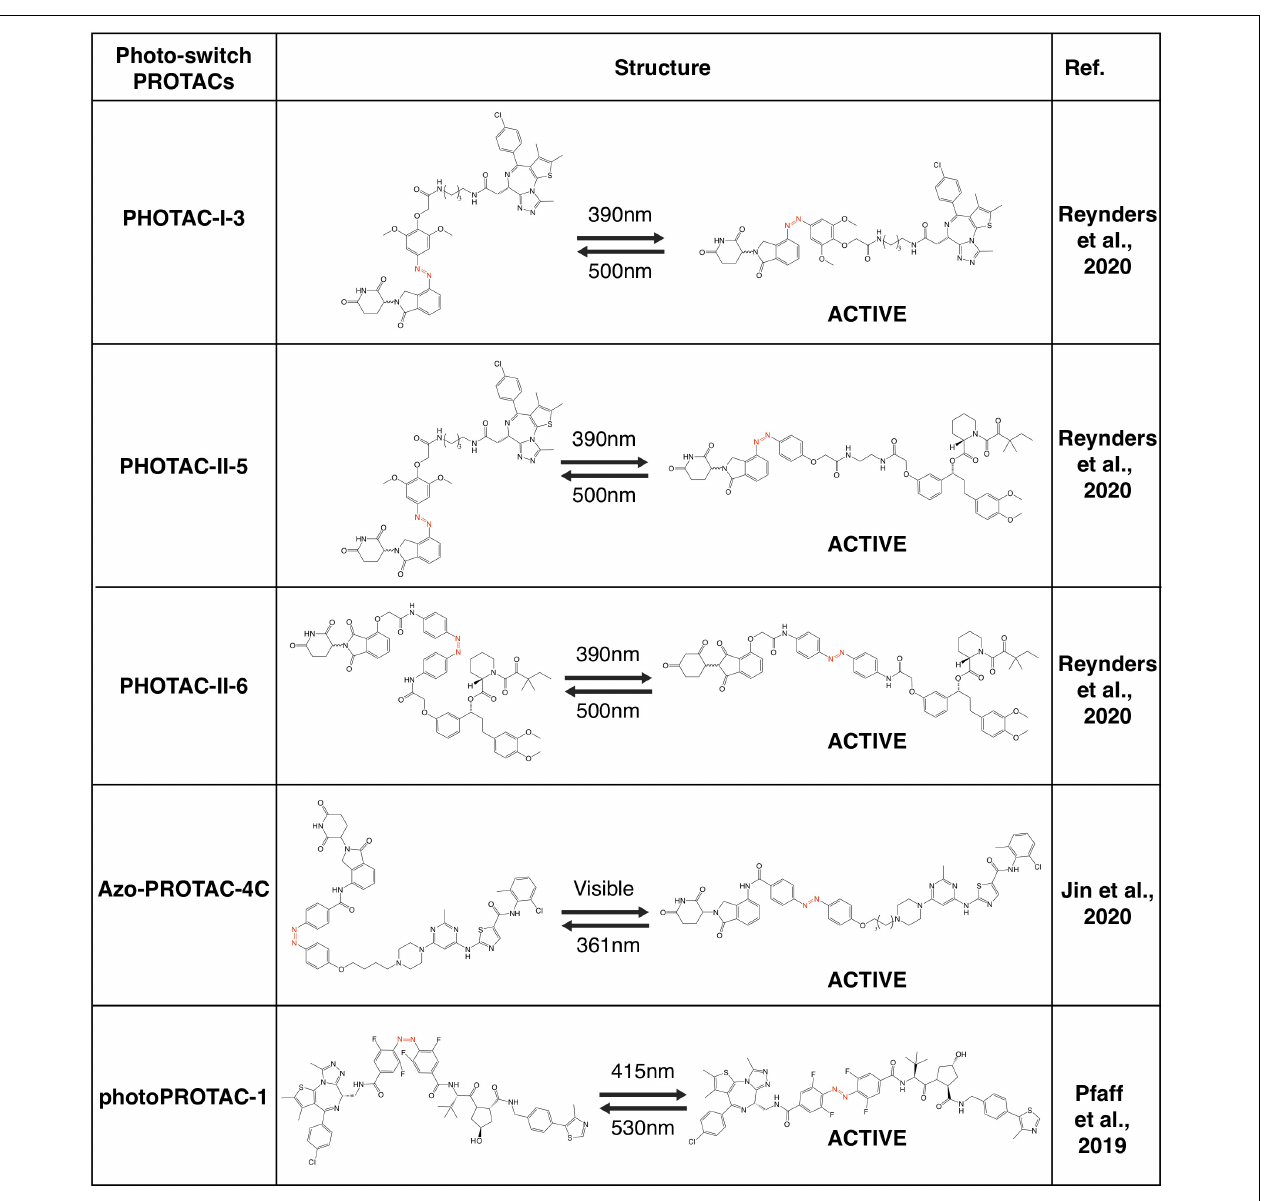
FIGURE 6 | Summary of photo-switch